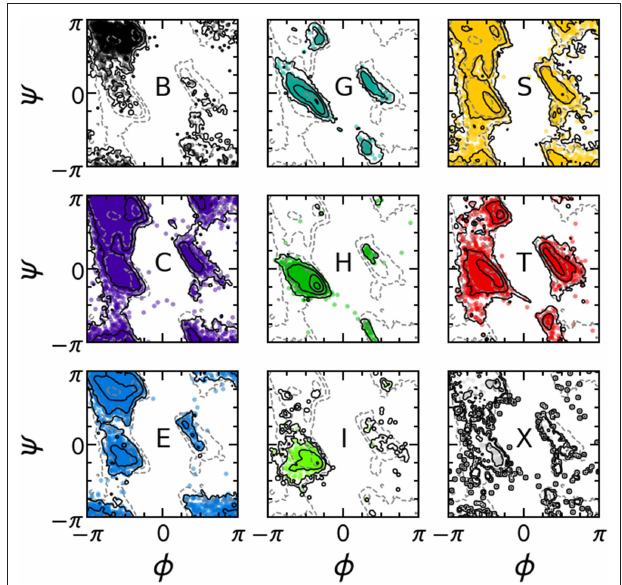
FIGURE 5 | Collection of 100,000 randomly selected ( φ , ψ ) pairs, separated according to the DSSP secondary structure classification of each pair. Solid contours correspond to the distribution of the secondary structure of interest; dashed contours correspond to the total distribution of all φ , ψ angles. Contours are equally spaced on a logarithmic